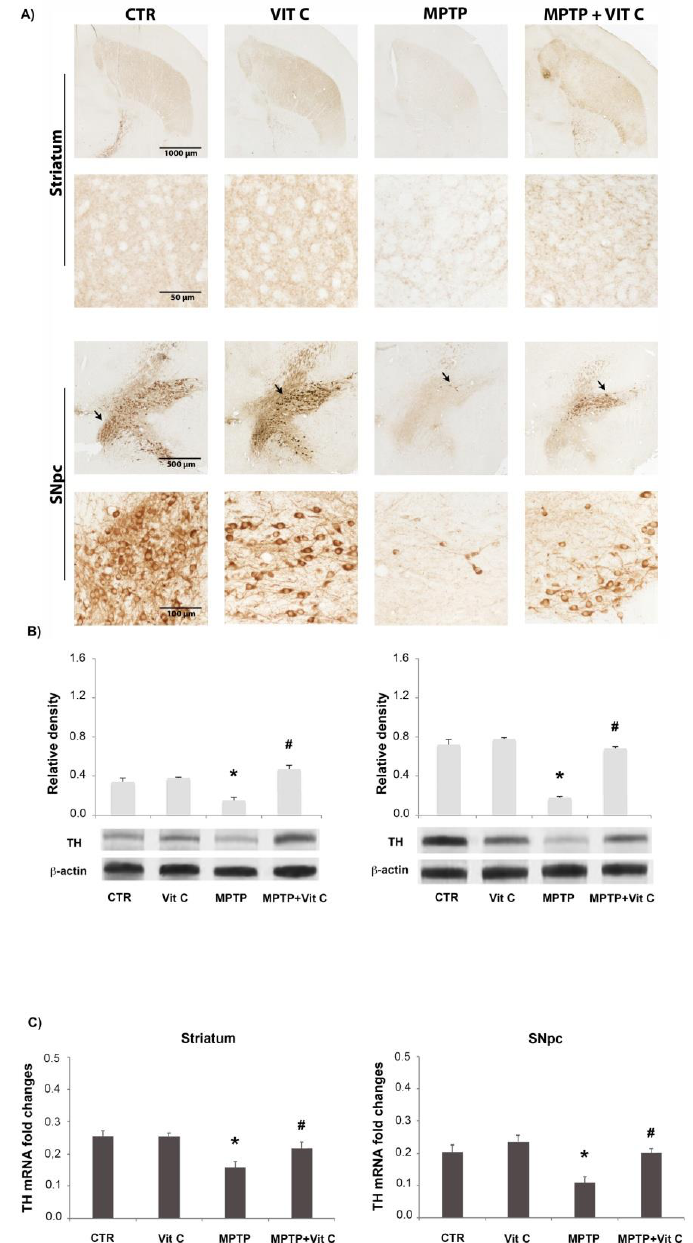
Figure 1. Tyrosine hydroxylase (TH) analysis. ( A ) TH immunoreactive catecholaminergic neurons of SNpcand their projections in the striatum (upper) and SNpc (lower) in controls (CTR), mice treated with Vitamin C (VIT C), MPTP, MPTP, and Vitamin C (MPTP+ VIT C). Scale bar: (striatum) upper 1000 μm(objective 4×), lower 50 μm (obj. 40×); (SNpc) upper 500 μm (obj. 4×), lower 100 μm (obj. 20×). In low magnification images, arrows point to TH immunoreactive cells shown in high magnification ones. ( B ) Western blotting detection and densitometric analysis of TH expression levels in controls (CTR), mice treated with Vitamin C (VIT C), MPTP, MPTP, and Vitamin C (MPTP+ VIT C) in striatum ( left ) and SNpc ( right ). Protein expression analysis values are expressed as arbitrary units after normalization against β -actin, using as a loading control ( n = 5 in each group, 5 replicates). ( C ) Real-time PCR analysis of TH mRNA expression levels in controls (CTR), mice treated with Vitamin C (VIT C), MPTP, MPTP, and Vitamin C (MPTP+ VIT C) in striatum ( left ) and SNpc ( right ). Results are presented as mRNA fold changes relative to GAPDH, used as resident control. Data are presented as mean ± SD (* p < 0.05 vs. CTR; # p < 0.05 vs. MPTP). Supplementary Figure S1 shows the full western blots of Figure